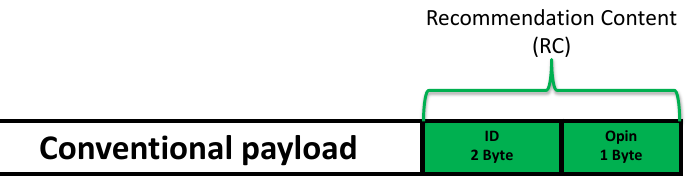
Figure 4. Piggybacking of Recommendation